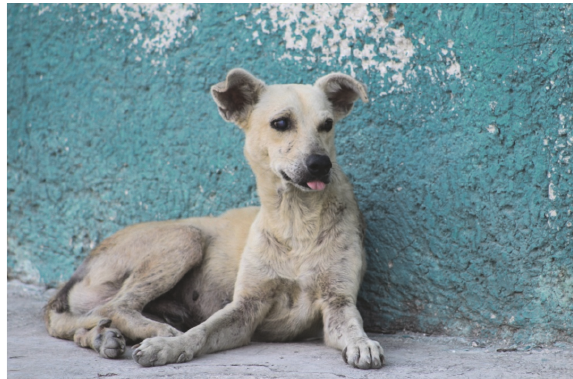
Figure 3: A male “malix” dog (standing) with good body condition (BCS 3) presenting a wound in the left former limb and diffuse alopecia in the thoracic